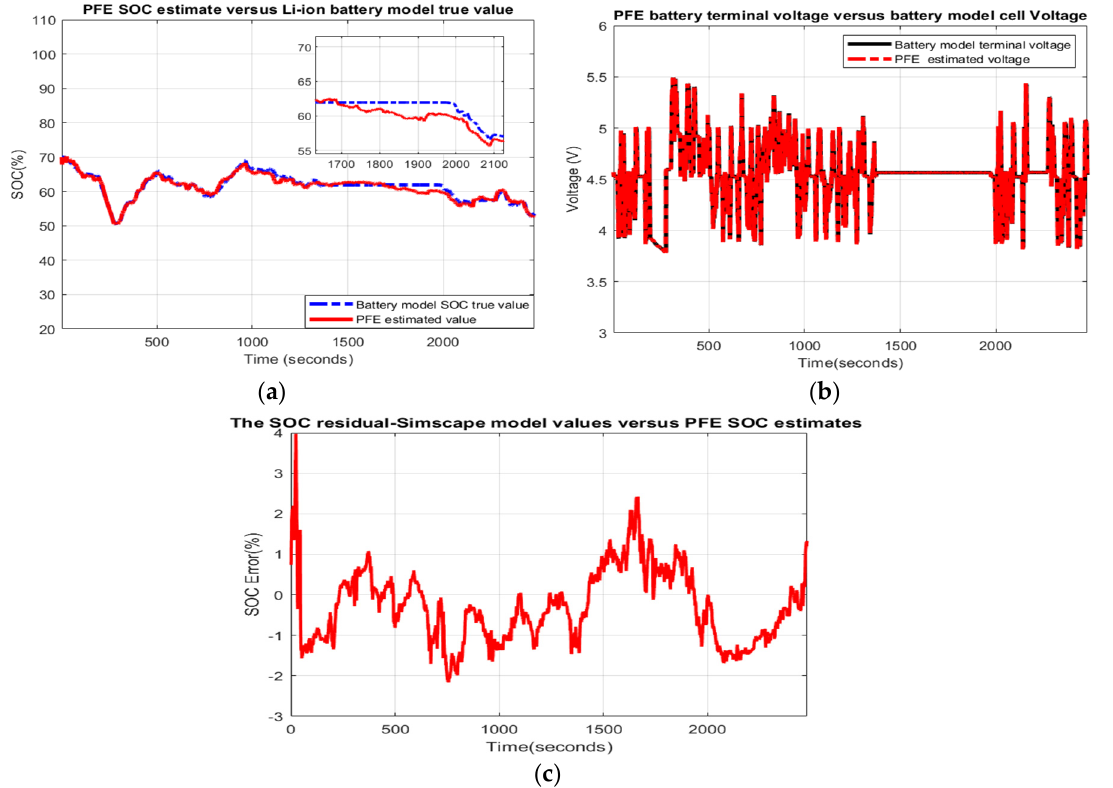
Figure A27. The MATLAB simulation results for Simulink Simscape Li-ion battery. ( a ) The PFE SOC value versus battery model SOC true value; ( b ) The PFE terminal output voltage versus battery model terminal output voltage true value; ( c ) The SOC residual. Batteries 2020 , 6 , x FOR PEER REVIEW